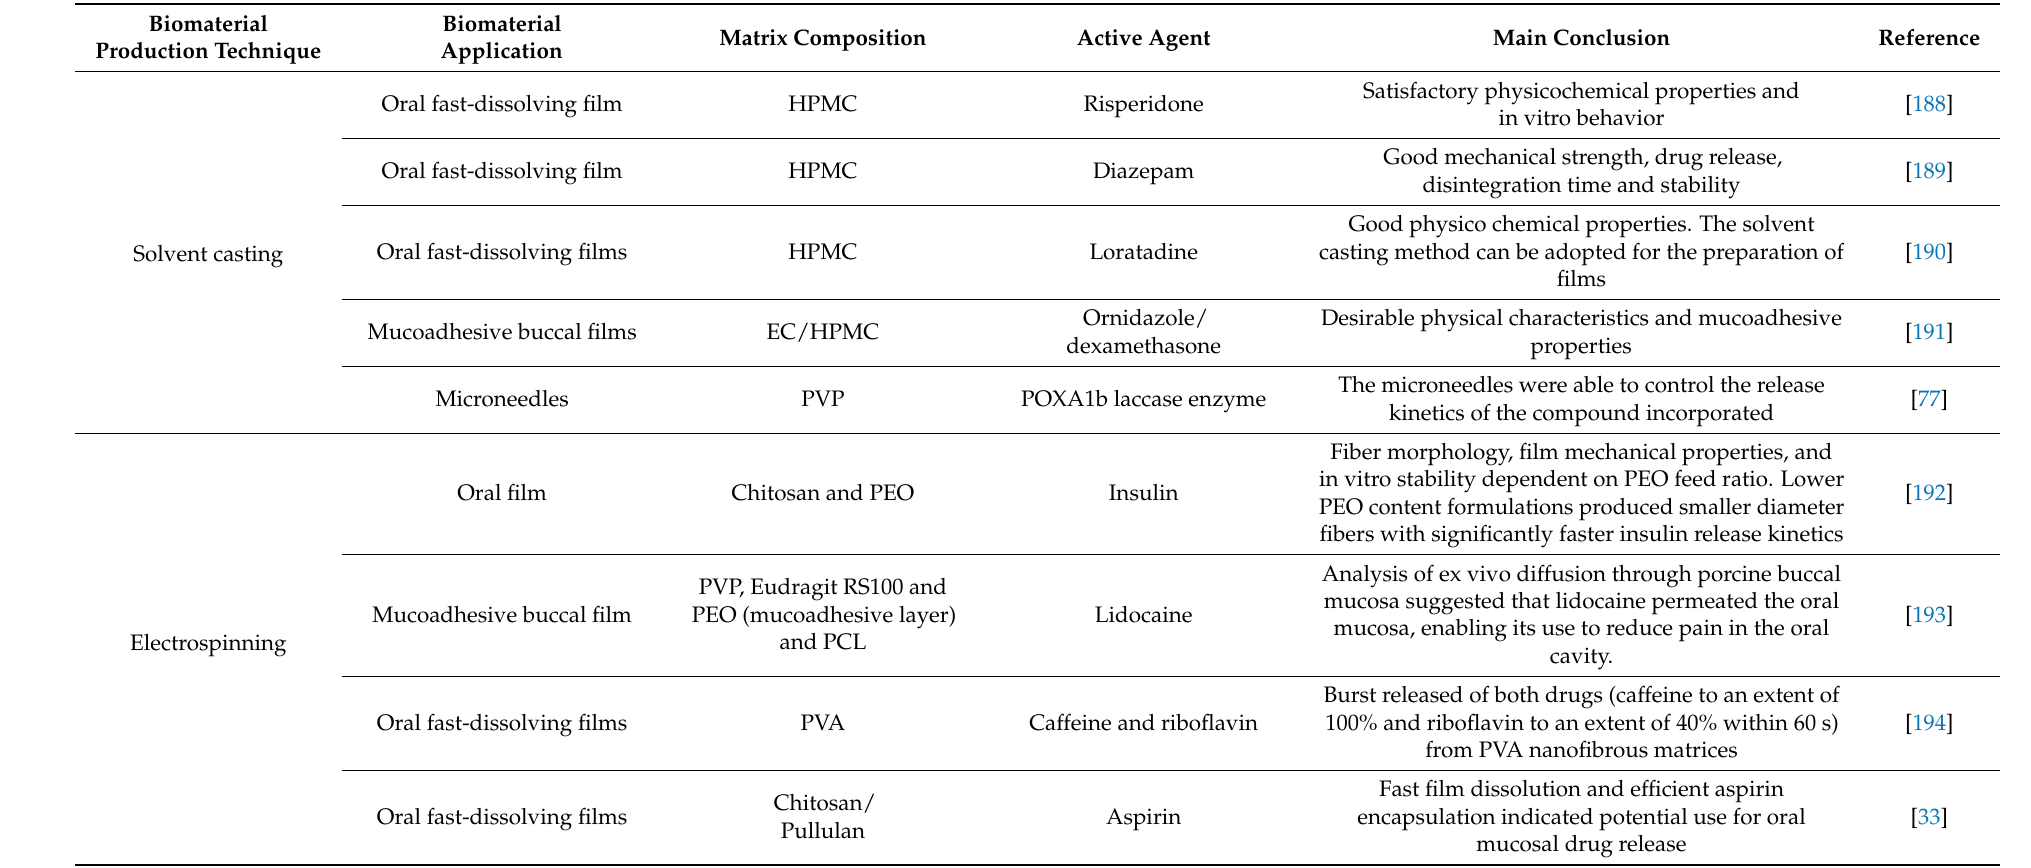
Table 4. Examples of techniques to prepare biomaterials, application, matrix composition, active agents incorporated and main conclusions